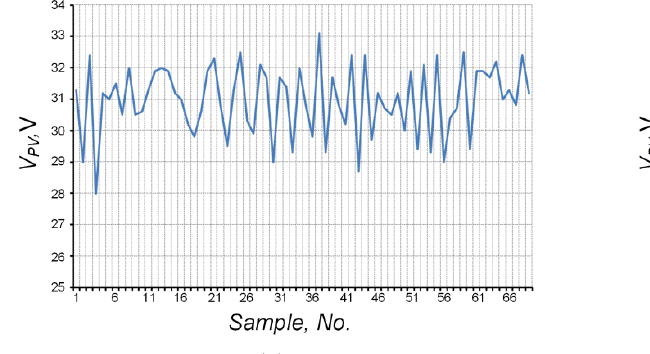
Figure 14. V PV vs. t of the PV module loaded by Skymax inverter: ( a ) daily characteristic; ( b ) be- ginning period of daily characteristic at low solar irradiance and low load; ( c ) start of inverter un- der nominal load; ( d ) nominal operation of inverter with active MPPT function.